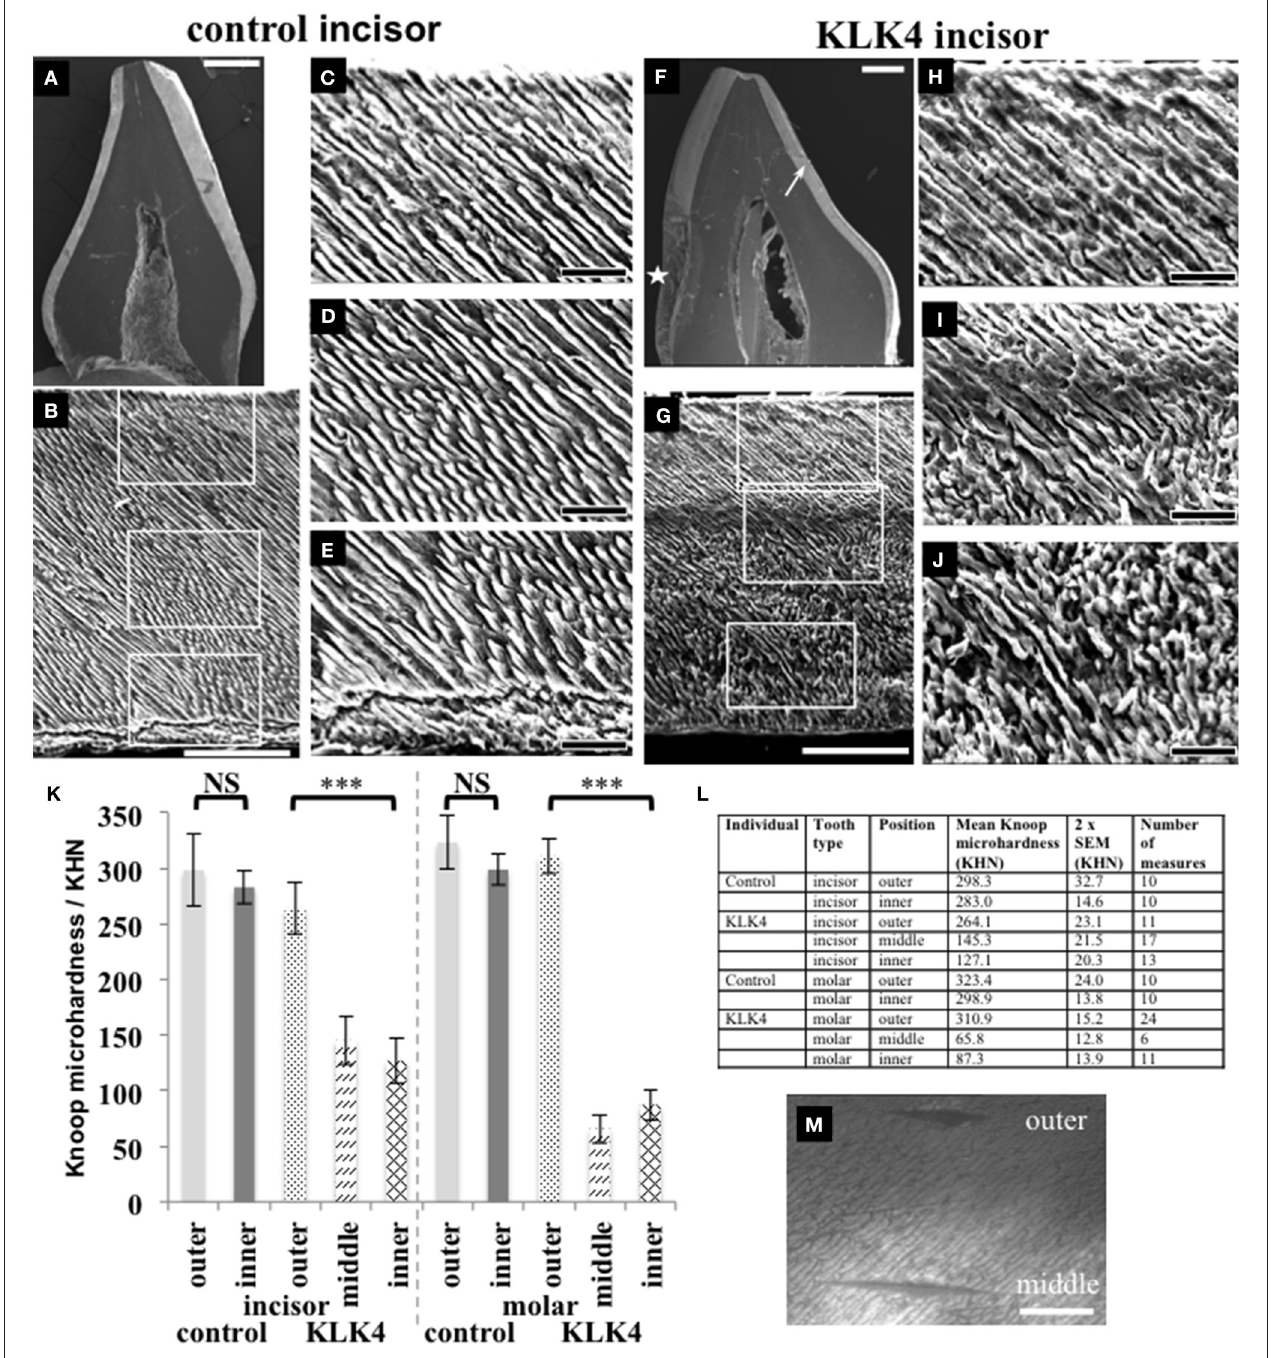
FIGURE 3 | SEM and microhardness testing of control and KLK4 teeth from individual V:1 (family 1). (A–E) : Control tooth; (F–J) : KLK4 tooth. (A) : Whole tooth longitudinal section. (B) : The enamel layer with the enamel surface shown at the top and the enamel-dentine junction at the bottom. White boxes indicate the positions of magnified images (C,D) and (E) respectively (top to bottom). (C–E) : outer (C) : close to the surface; middle (D) and inner (E) : close to the EDJ, enamel. (F) : Whole tooth longitudinal section—note the clear demarcation in the enamel layer between the inner and outer enamel on the lingual side of the tooth (arrow). An area of decay is present on the one side of the tooth (star). (G) : The enamel layer with surface at the top and the enamel-dentine junction at the bottom. White boxes indicate the positions of magnified images (H–J) respectively (top to bottom). (H–J) : outer (H) : close to the surface: middle (I) and inner (J) : close to the EDJ, enamel. (K) : Knoop microhardness testing for control and KLK4 incisor and molar teeth. Error bars represent 2x standard error of the mean. Brackets indicate the conditions for which unpaired, two-tailed T -tests were undertaken. Results are abbreviated as follows: NS; not significant, i.e., p > 0.05; *** significant at p < 0.001. (L) : Knoop microhardness testing results in table form. (M) : Light microscopy image showing two indentations made around 100 µ m apart on the KLK4 incisor tooth, one in the outer enamel layer and the other in the middle enamel layer. Scale bars represent (A,F) : 1 mm; (B,G) : 100 µ m; (C–E) and (H–J) : 25 µ m; (M) : 50 µ m.